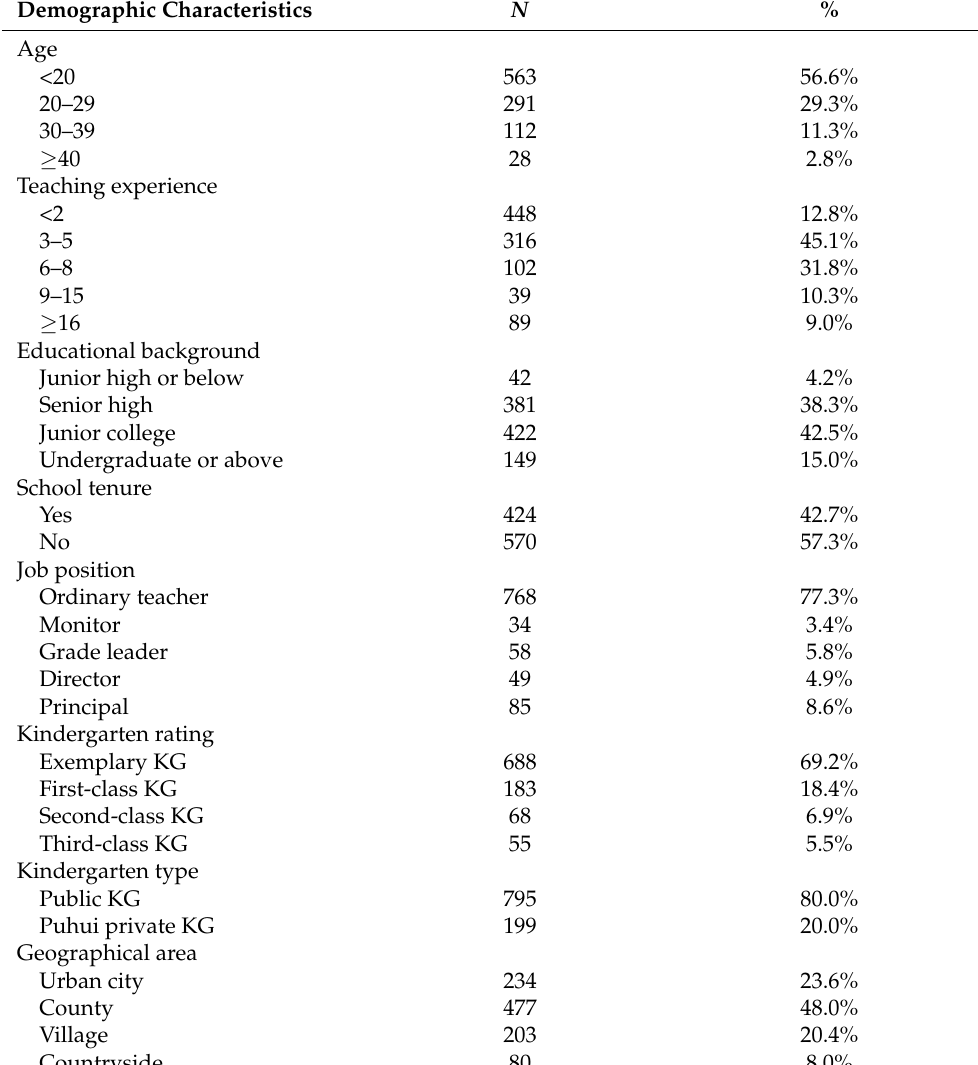
Table 1. Participants’ characteristics ( N =